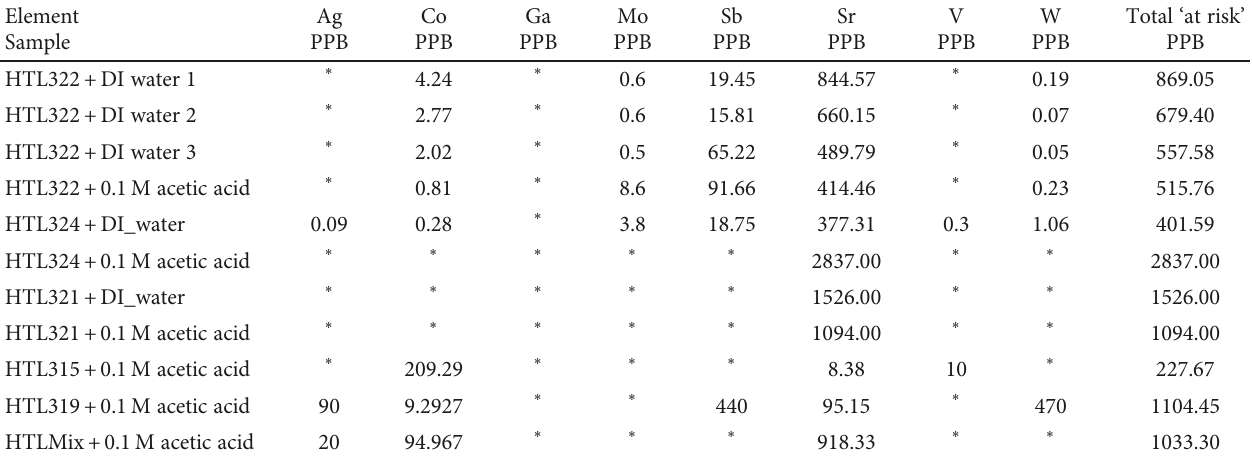
Table 7: Concentration of the “ at risk ” elements in each leachate from the fl ow-through reaction.